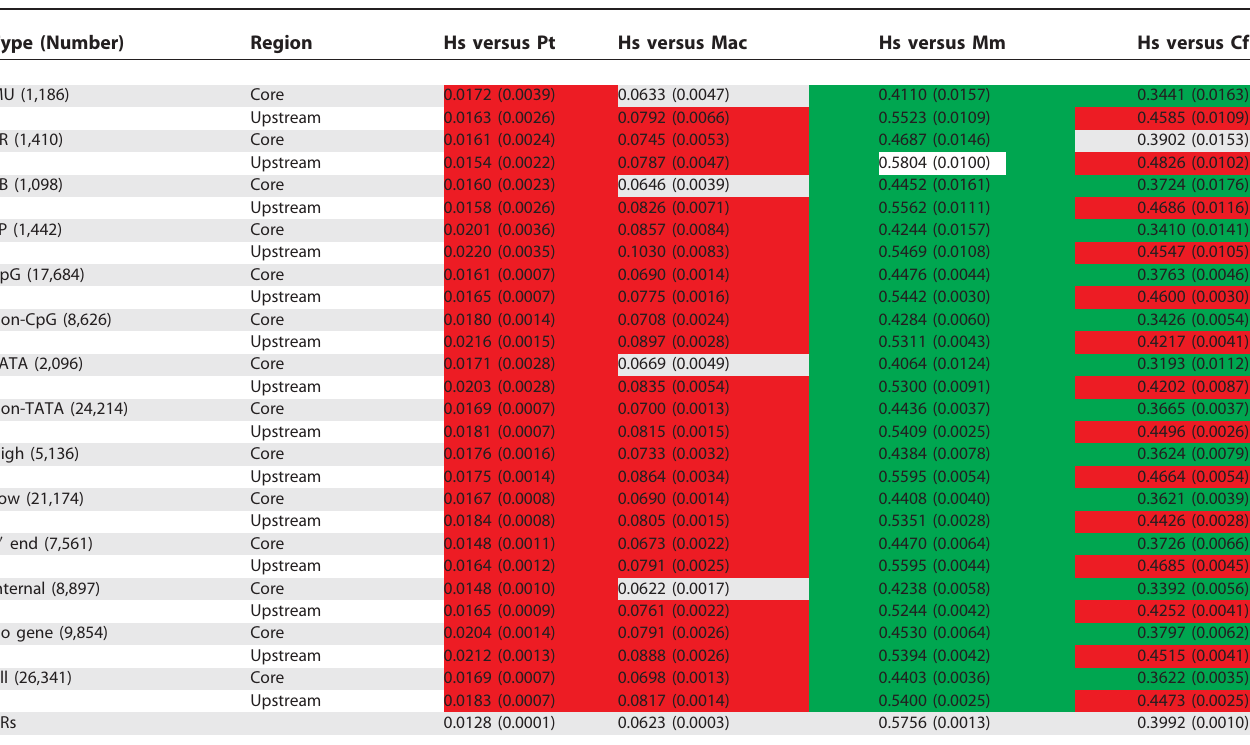
Table 2. Substitution Rate Estimates for Human